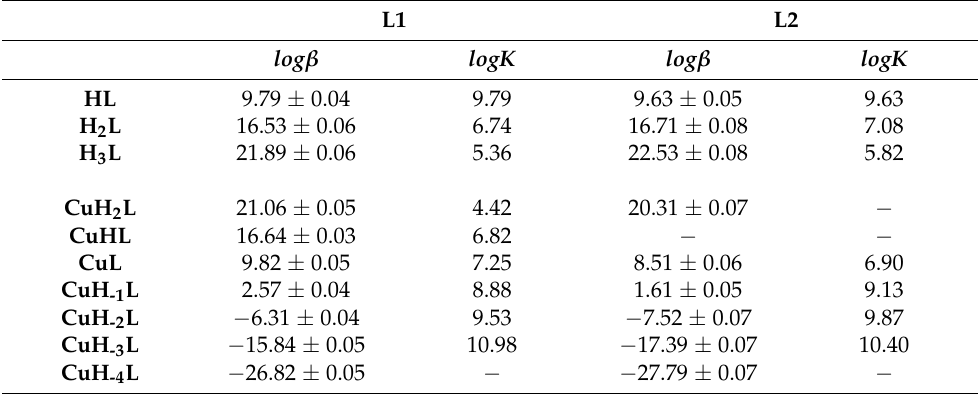
Table 1. The protonation constants and stability constants for ligands L1—c(GlyHisProHisLys) and L2—c(GlyHisGlyHisLys) calculated by fitting potentiometric curves by